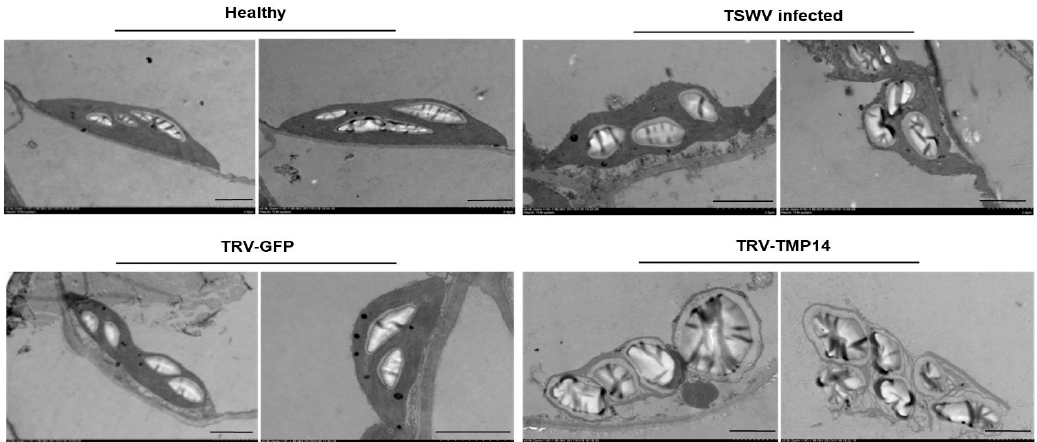
Figure 4. Transmission electron micrographs of N. benthamiana cells. The chloroplasts of TSWV-infected plants were abnormal and had larger starch granules. In the NbTMP14 knock-down plants, most chloroplasts were broken, and starch granules were enlarged. Scale bars represent 2 µ